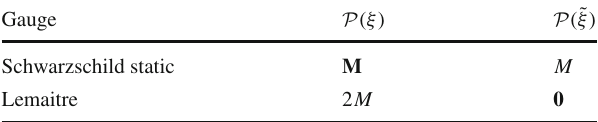
Table 1 Noether charges in the Schwarzschild static and Lemaitre gauges for different choices of the vector field ξ Gauge P (ξ) P ( ˜ ξ) Schwarzschild static M M Lemaitre 2 M